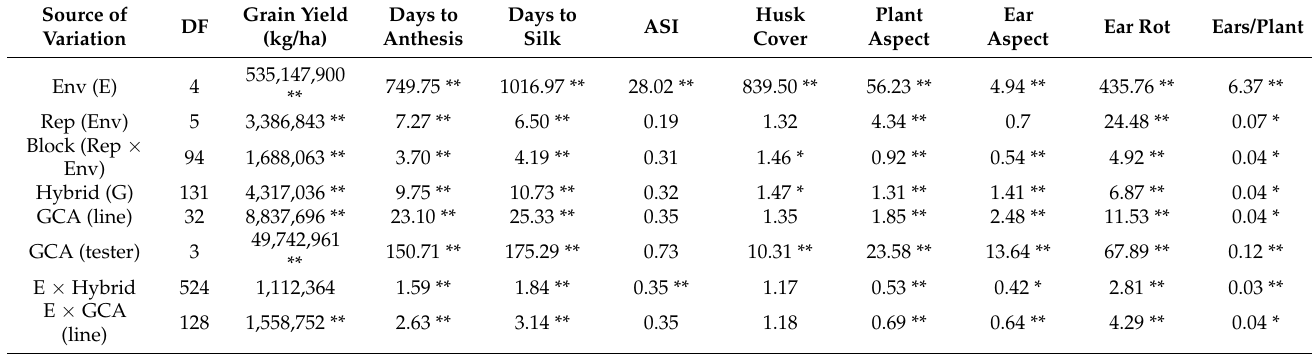
Table 4. Mean squares from the line × tester analysis of variance of grain yield and other traits of 132 hybrids evaluated across optimal conditions at five locations in Nigeria during the 2015 and 2016 growing